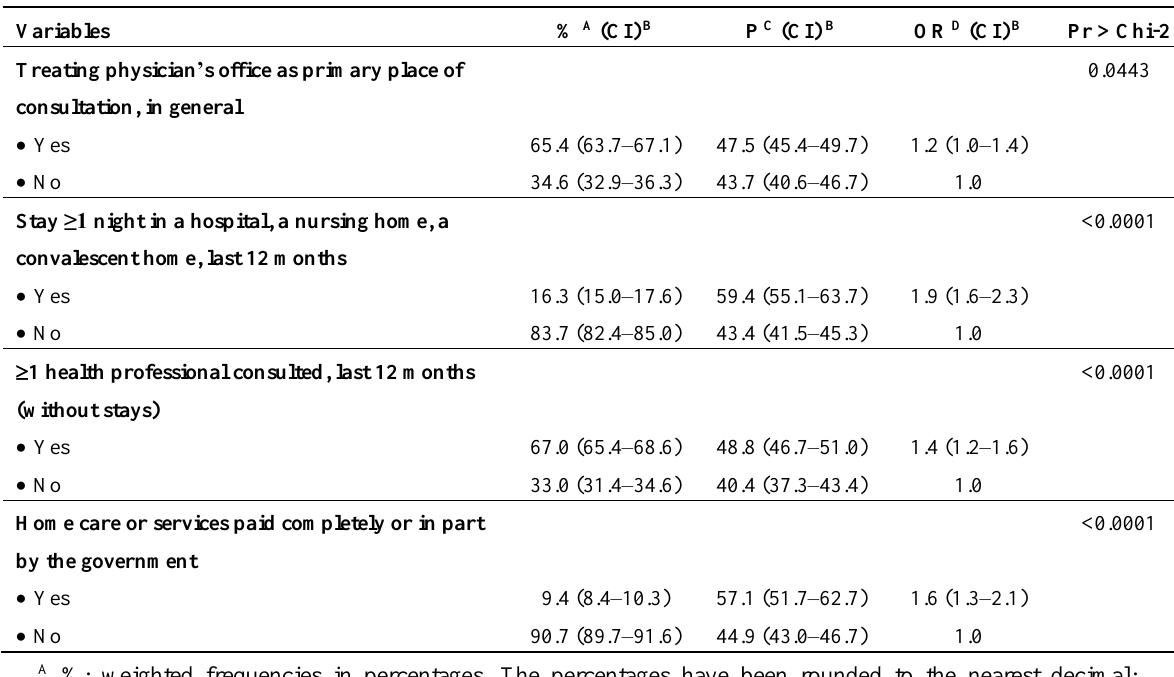
Table 7. Prevalence of reported adverse health impacts, very hot and humid summer conditions, based on health or home care and